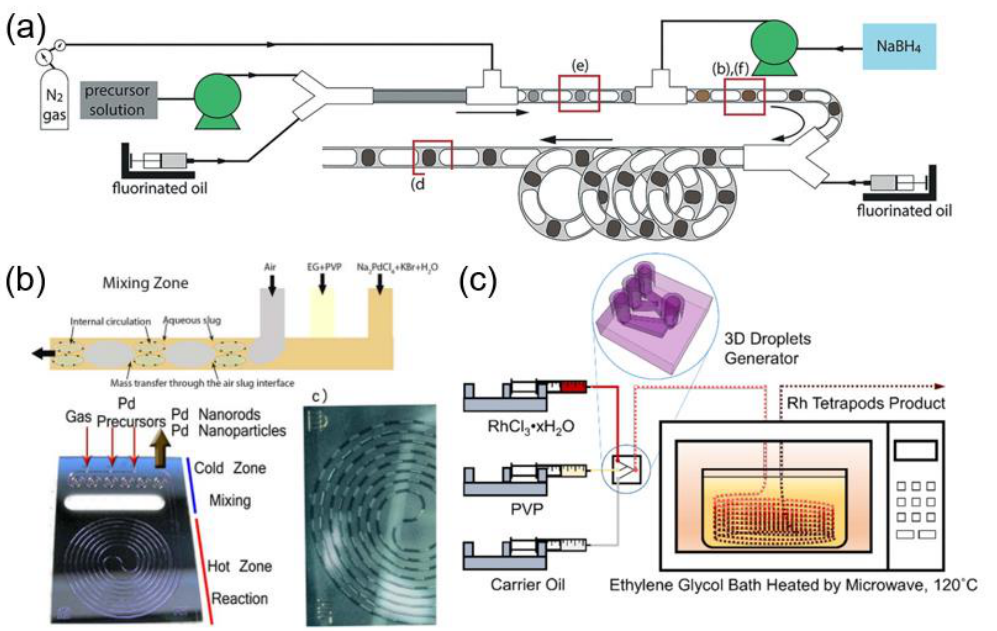
Figure 6. ( a ) Schematic illustration of the triphasic segmented flow reactor for the synthesis of ultra-small palladium nanoparticle (reproduced from [50], with permission from the Royal Society of Chemistry, 2017). ( b ) Schematic illustration of the segmented flow generated in the mixing zone of a hydrophilic microfluidic reactor (reproduced from [51], with permission from the Wiley-VCH Verlag GmbH & Co, 2016). ( c ) Schematic illustration of the two-phase flow microfluidic system for fabrication of rhodium tetrapod product (reproduced from [52], with permission from the American Chemical Society, 2017).